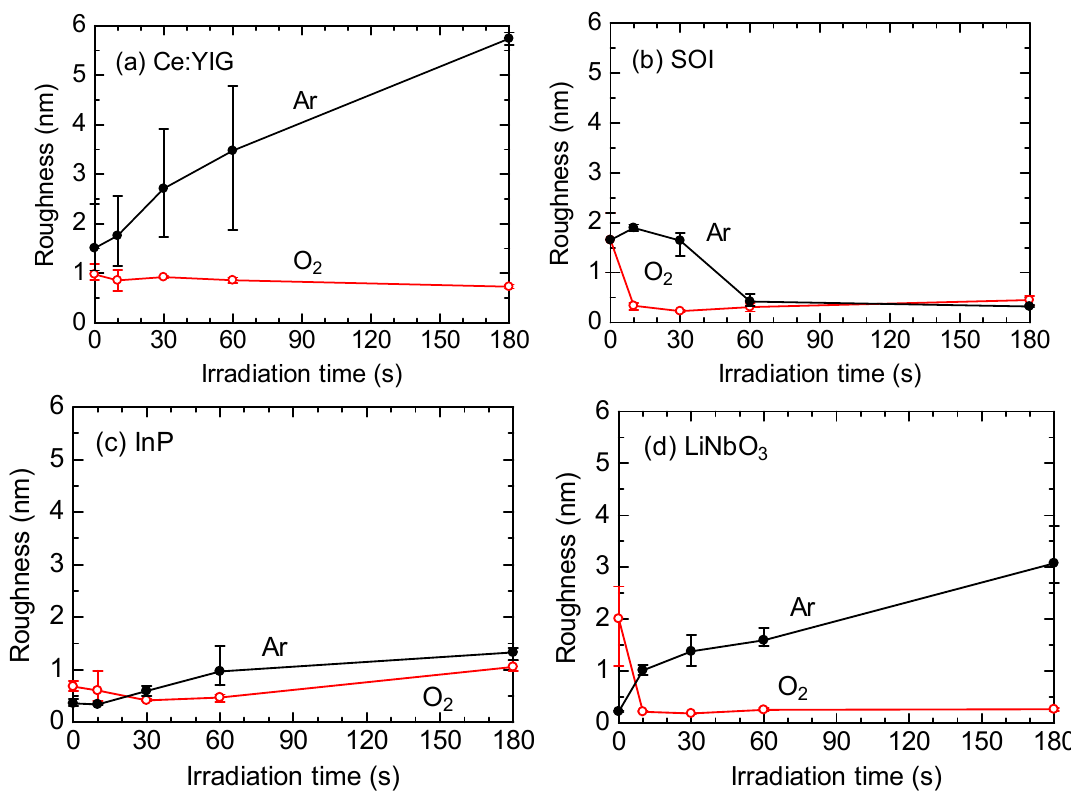
Figure 2. Measured surface roughness of ( a ) Ce:YIG, ( b ) silicon-on-insulator (SOI), ( c ) InP, and ( d ) LiNbO as a function of plasma irradiation time 3